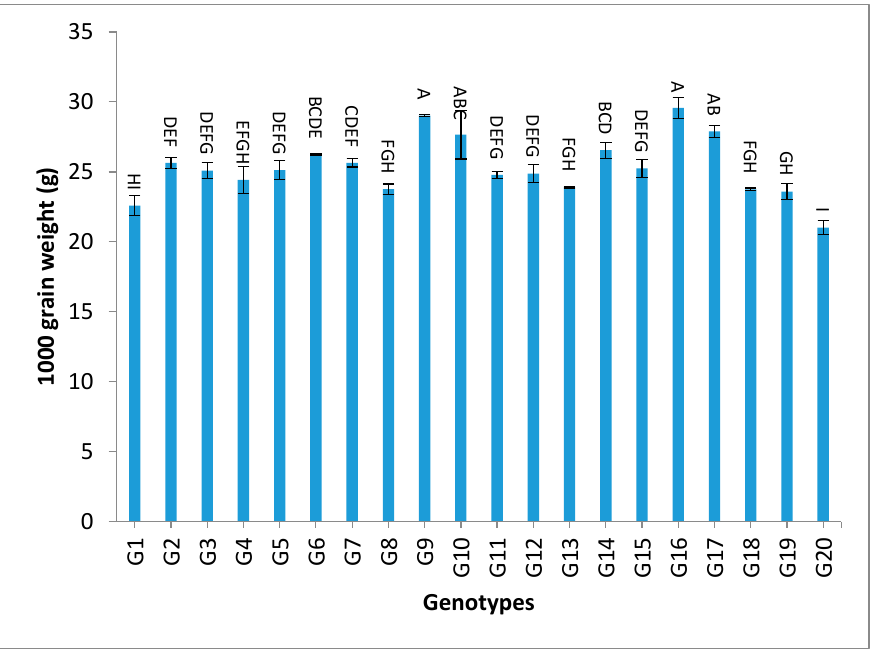
Figure 6. The mean numbers of filled grains per panicle of twenty rice genotypes over the two years. Bar represents the standard deviation.